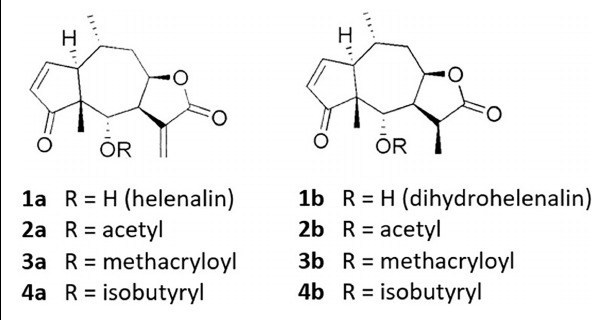
FIGURE 1 | Sesquiterpene lactones of Arnica montana investigated in this study. Adopted from Douglas et al.